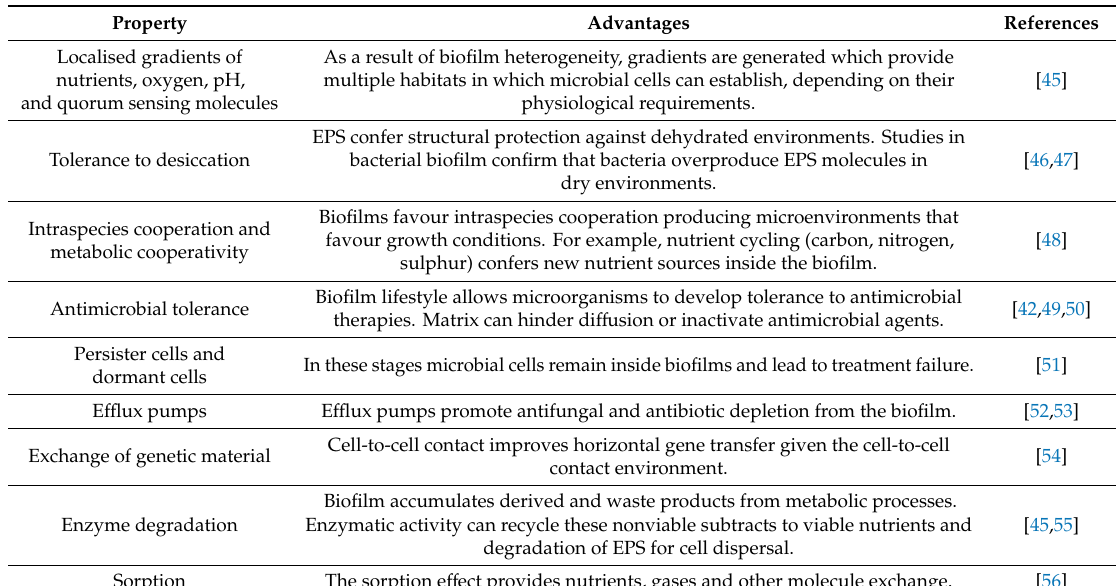
Table 3. Biofilm mechanisms for adaptation to the